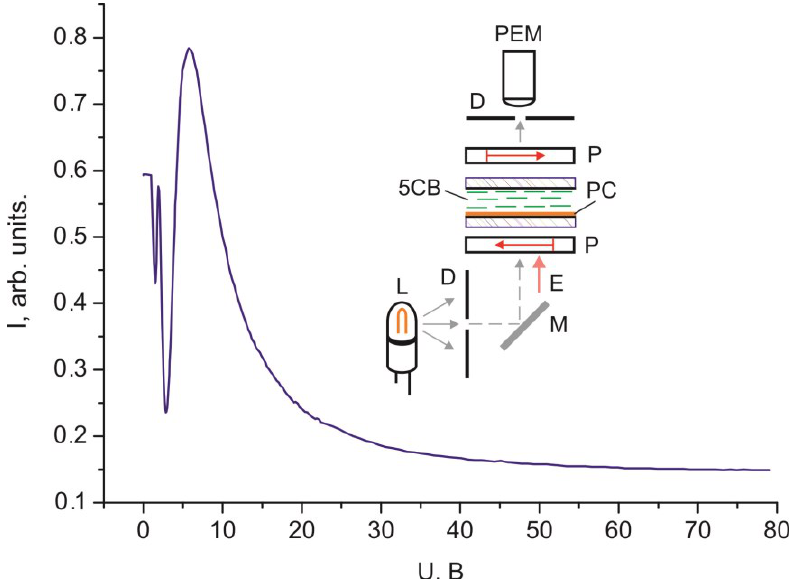
Figure 2. Dependence of intensity I of white light passed through the 30 µm thick planar 5CB layer with domains formed on the PC surface in crossed polarizers on voltage U of electric field E .